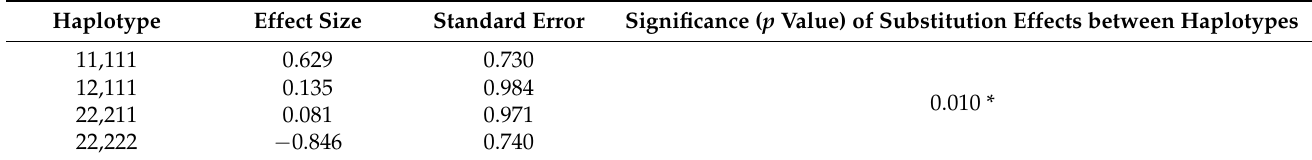
Table 1. Haplotype effects from CYP19A1 locus on milk yield in Holstein population. * refers to p value <